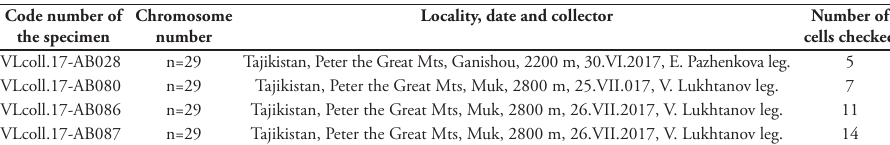
Table 2. Chromosome number in studied samples of Melitaea kotshubeji kotshubeji.